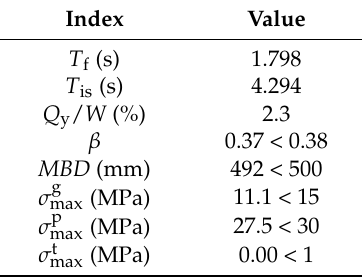
Table 6. Critical design parameters and indexes of the isolated tall building with NFVDs.